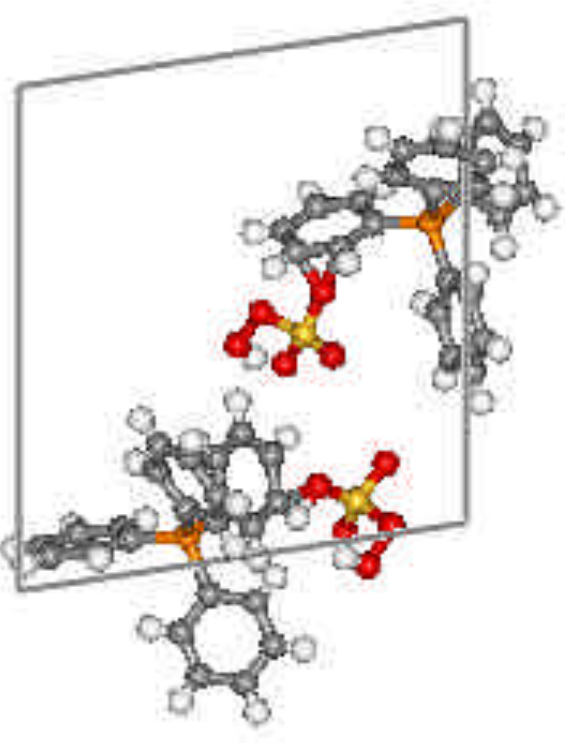
Figure 1. A view of the two independent molecules of ( 4 ) in the asymmetric